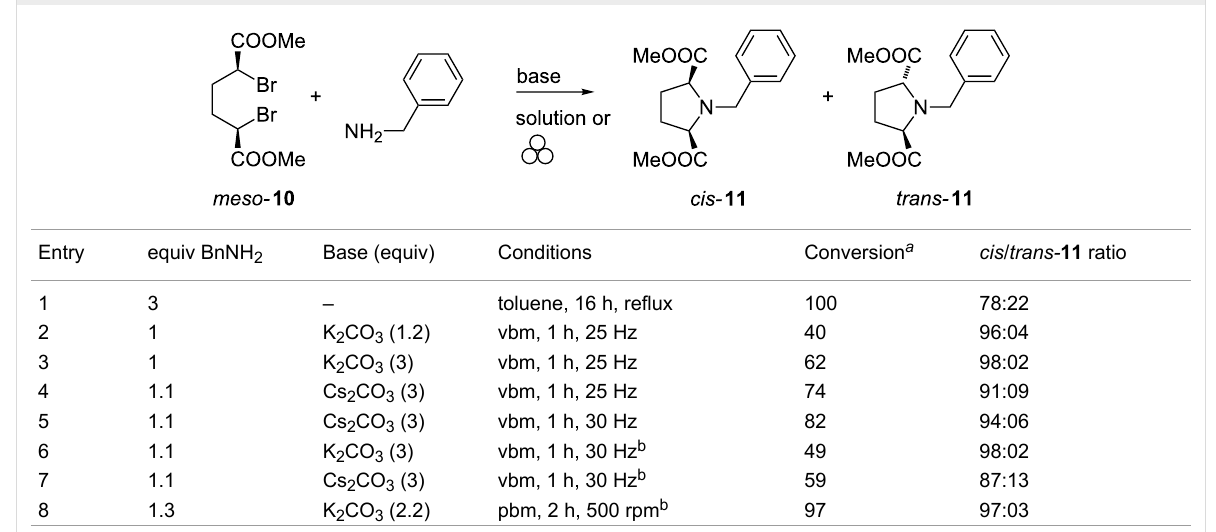
Table 2: Optimization of the substitution